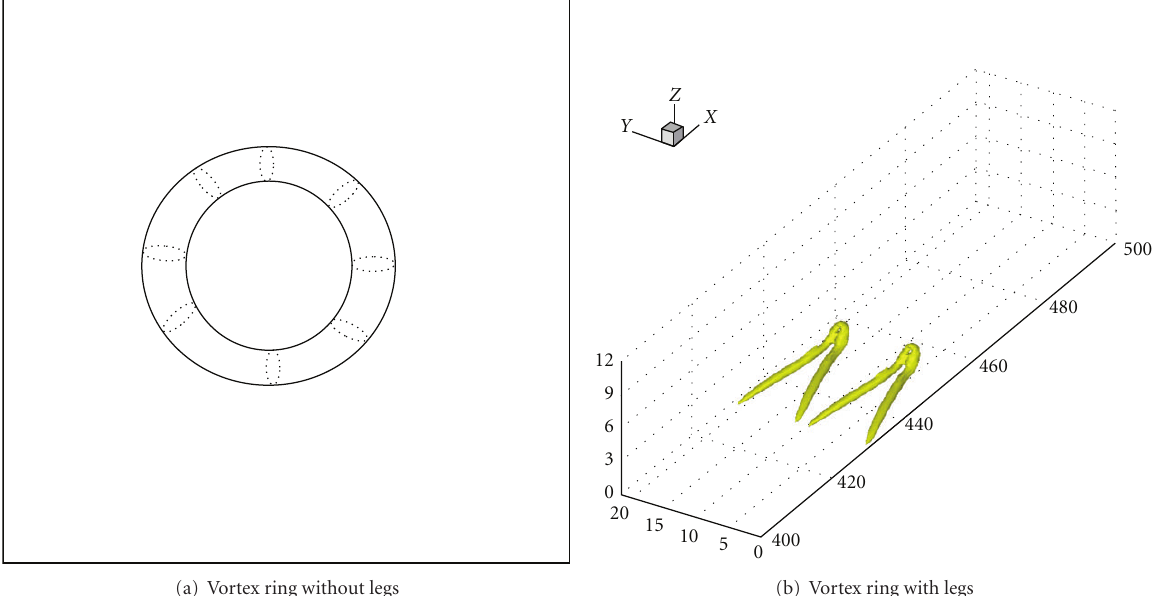
Figure 13: Vortex rings with or without legs.